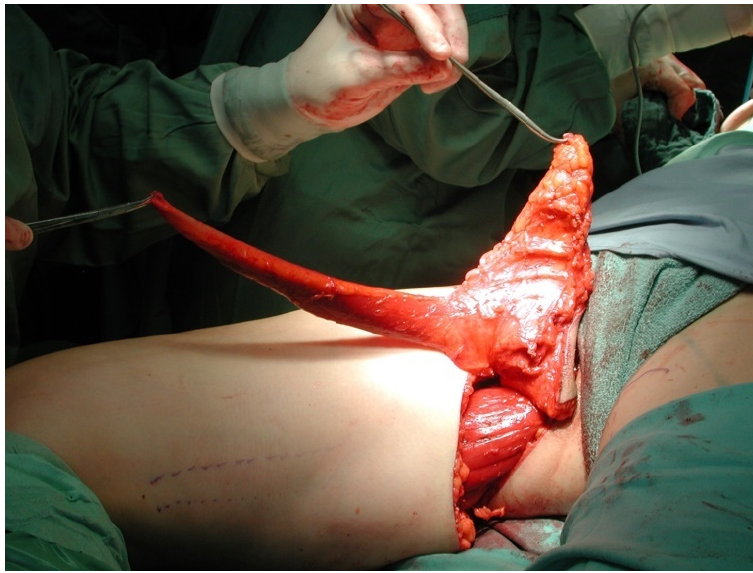
Figure 3. Intraoperative image after unilateral TMG flap raise.